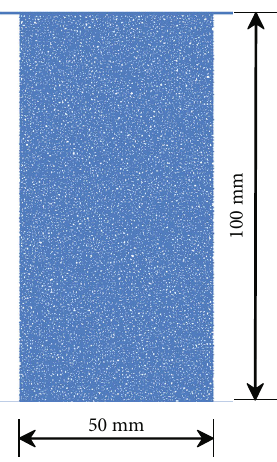
Figure 6: PFC numerical